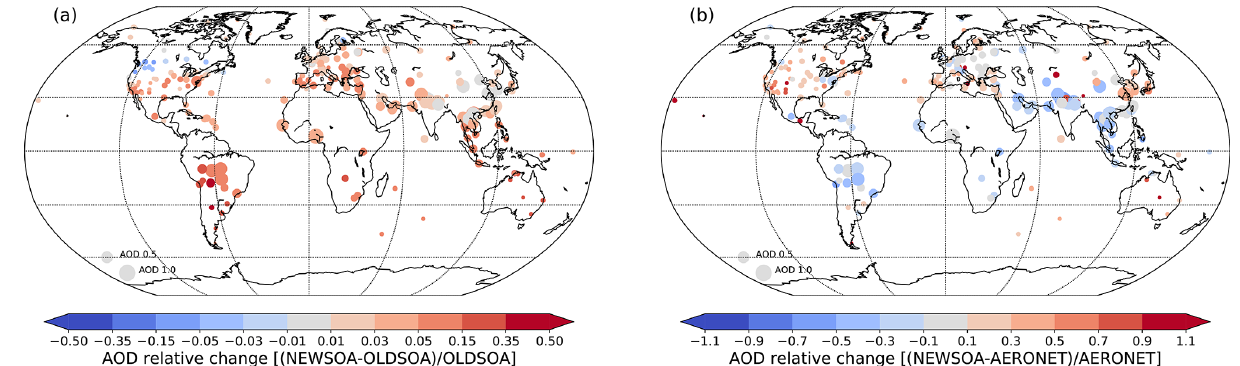
Figure 15. Annual relative change in AOD at AERONET stations between NEWSOA and OLDSOA (a) . Red indicates an increase and blue a decrease compared to OLDSOA. Panel (b) shows the annual mean relative bias in NEWSOA at AERONET stations. In both panels larger markers indicate higher observed